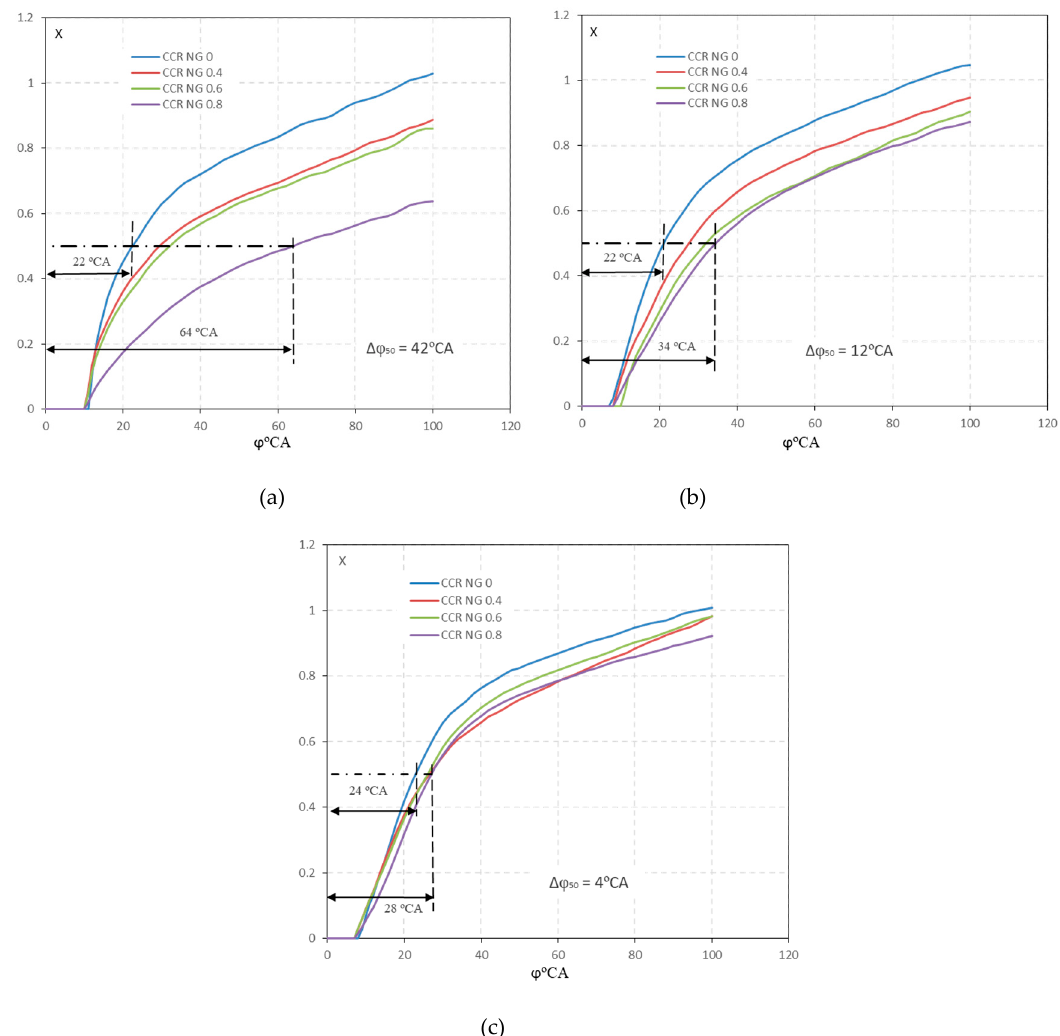
Figure 10. Dual-fuel engine CCR NG fuel portion influence on heat release characteristics: ( a ) HLM; ( b ) MLM; ( c ) LLM.